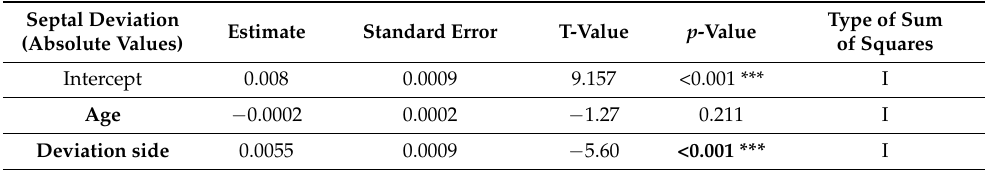
Table 4. Results of the Multiple Linear regression between the dependent variable of septal devia- tion (absolute values) and the independent variables of age and deviation side. Asterisks indicate significance: * p -value ≤ 0.05; ** p -value ≤ 0.01; *** p -value ≤ 0.001. Septal Deviation (Absolute Values)